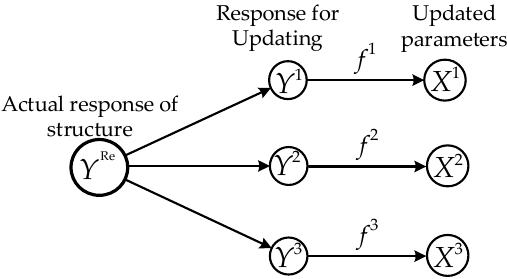
Figure 1. Schematic diagram of multi-alternatives in model updating.